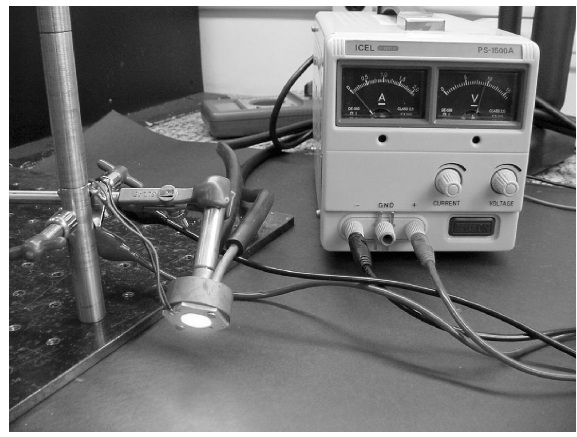
Figure 3 - LED-based device emitting red light at an emission peak at 626 nm.